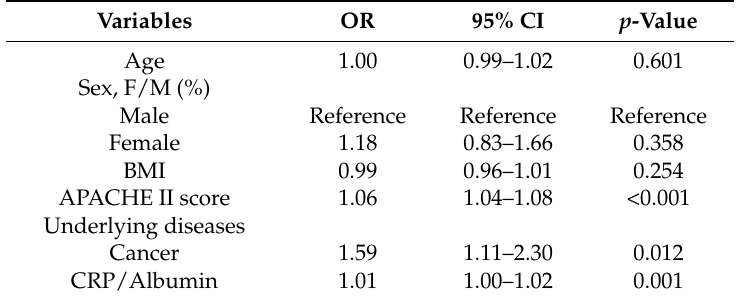
Table 2. Multivariate analysis to predict 28-day mortality after ICU